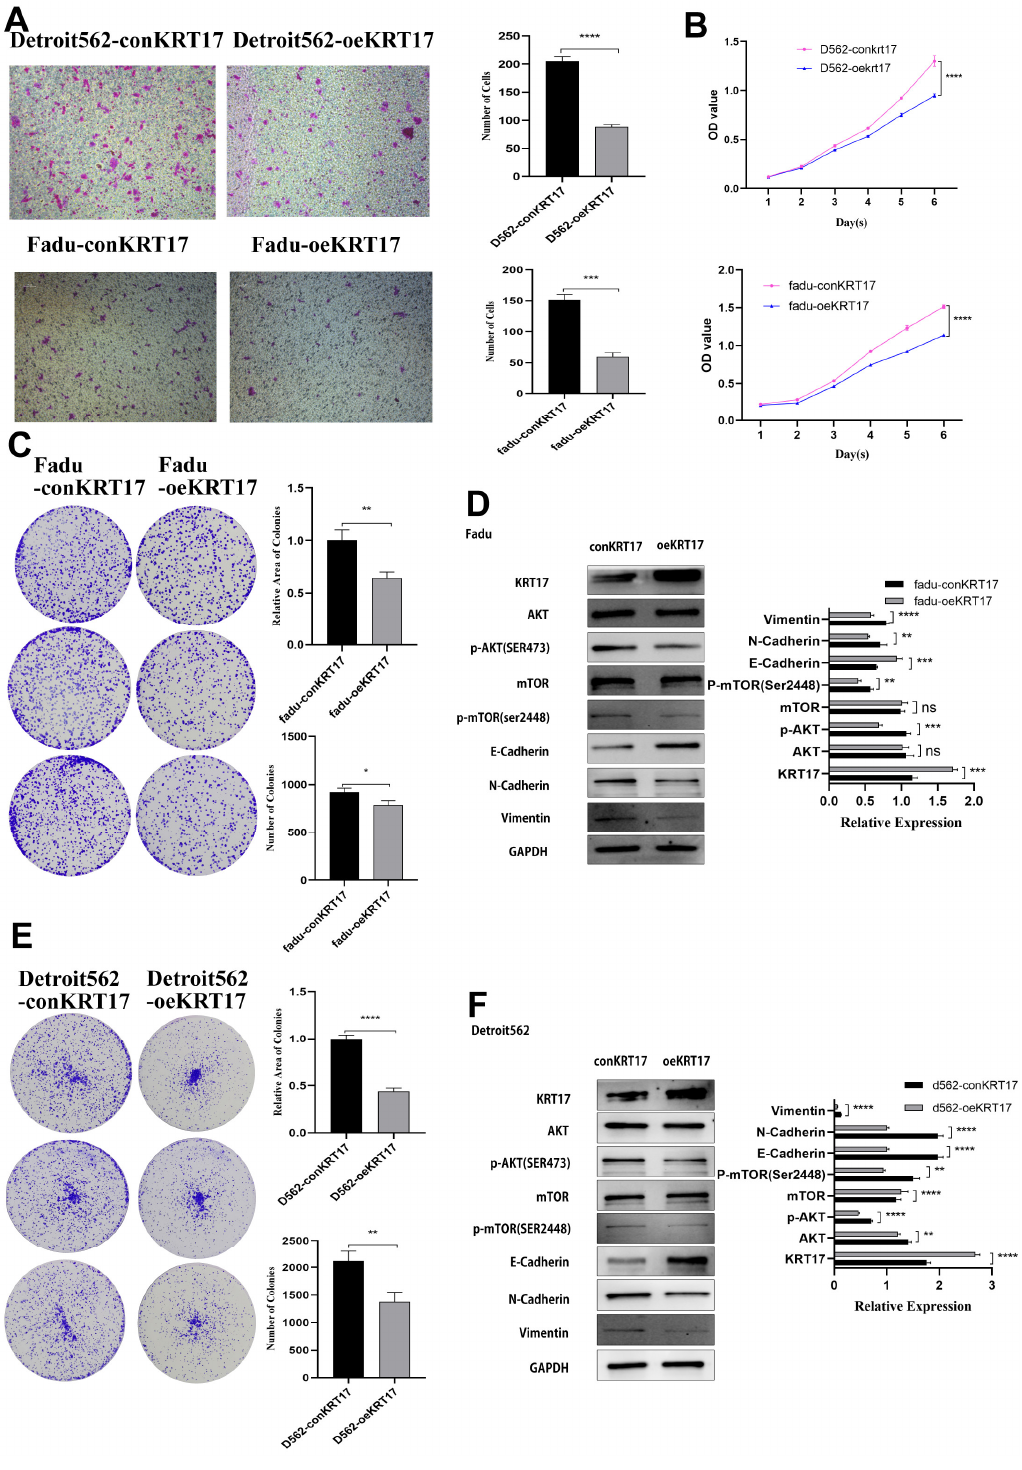
Figure 7. The proliferation and metastasis ability of tumor cells were significantly decreased in Fadu and Detroit562 cell lines overexpressed with KRT17. ( A , B ) Fadu and Detroit562 cell proliferation was inhibited after overexpressed with KRT17 showed by transwell and CCK-8 assay. ( C , D ) Colony formation assay and western blotting of Fadu cells after overexpressed with KRT17. ( E , F ) Colony formation assay and western blotting of Detroit562 cells after overexpressed with KRT17. The figures were captured under 10 × 10 microscope. * p < 0.05; ** p < 0.01; *** p < 0.001; **** p < 0.0001; ns no significance. The uncropped bolts are shown in Supplementary Materials File